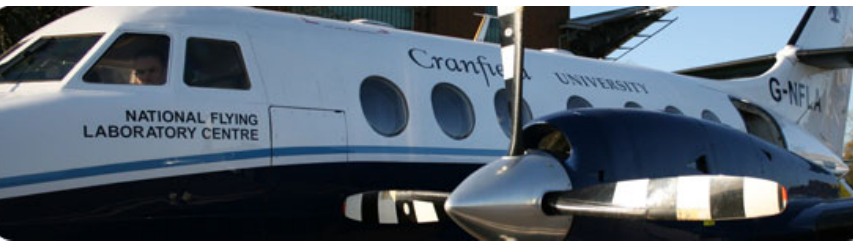
Figure 2 – Flying laboratory Jetstream 31, Cranfield